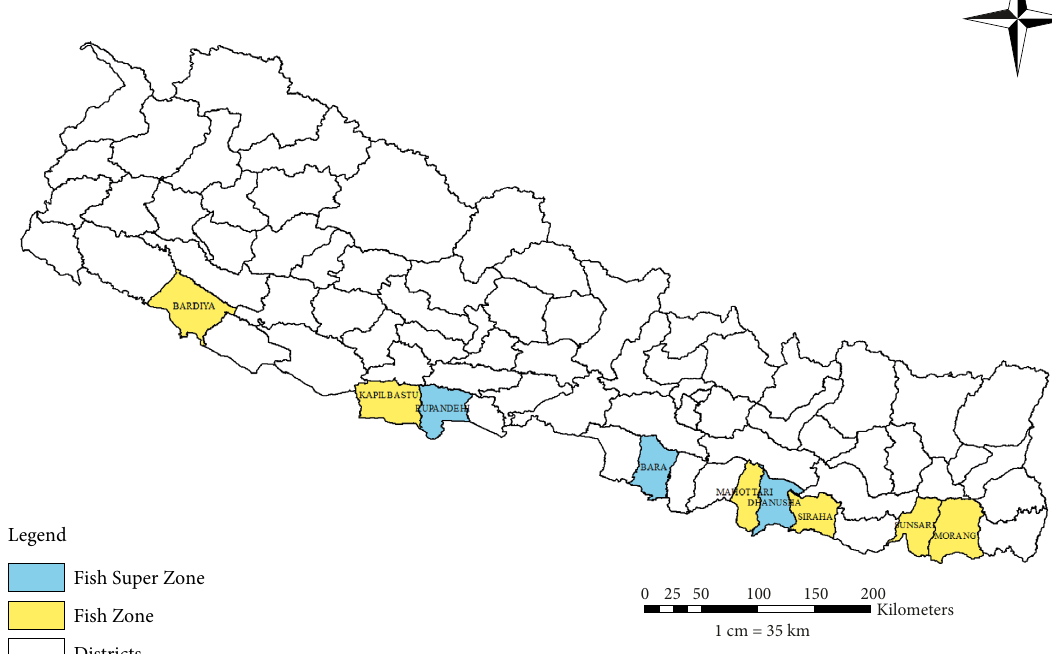
Figure 8: Map of Nepal showing fish super zone and fish zone. Map prepared from data available at